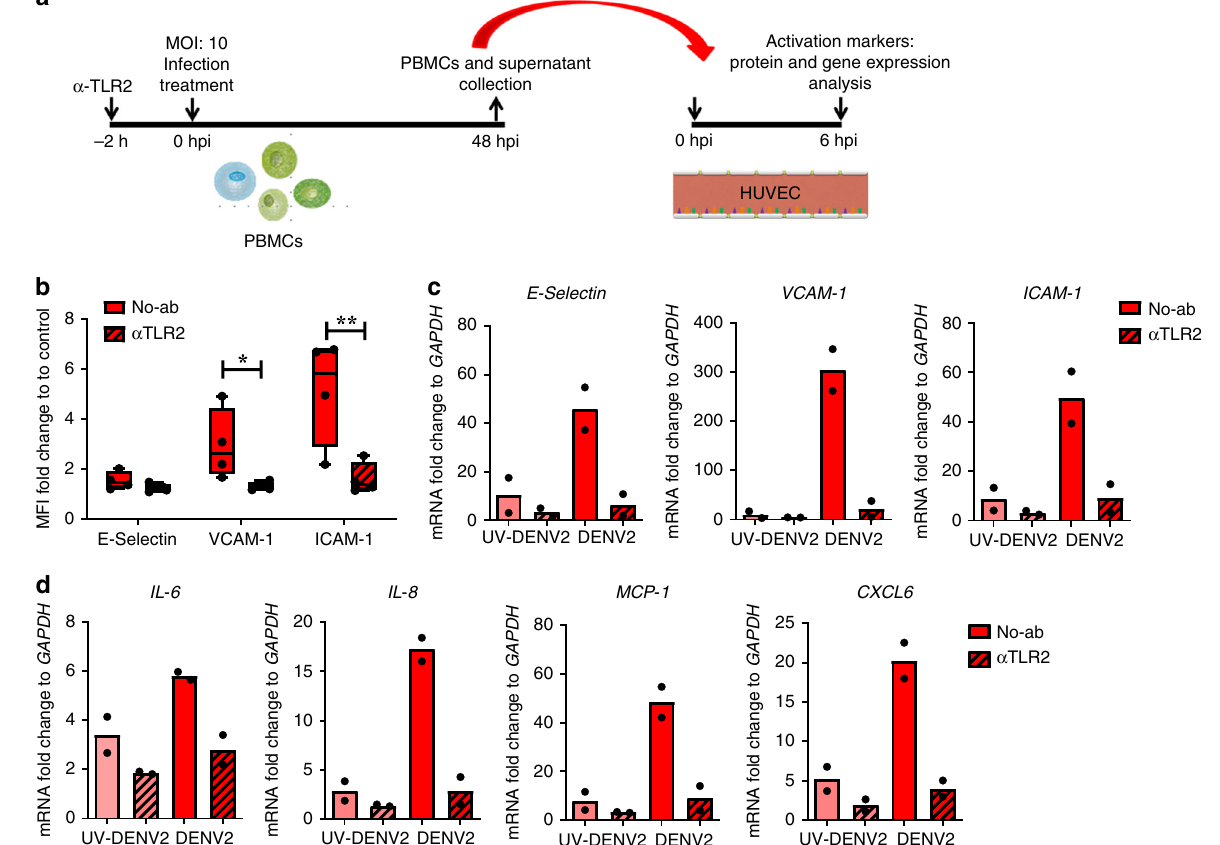
Fig. 4 Active DENV infection induces in fl ammatory mediators in a TLR2-dependent manner. a HUVEC were incubated for 6 h with cell-free supernatants from PBMCs infected in the presence or absence of TLR2 blockade. b Boxplots show the fold-changes in surface expression of E-selectin, VCAM-1 and ICAM-1 compared to the respective mock ( n = 4, paired one-tailed t test, * P < 0.05; ** P < 0.01). The horizontal line represents the median and the whiskers the minimum and maximum values. c Fold-changes in gene expression levels of E-selectin , VCAM-1 , and ICAM-1 relative to the respective mock ( n = 2). d Fold-changes in gene expression levels of IL-6 , IL-8 , MCP-1 , and CXCL6 relative to the respective mock ( n = 2). N refers to the number of independent biological experiments in HUVEC. Source data are provided as a Source data fi